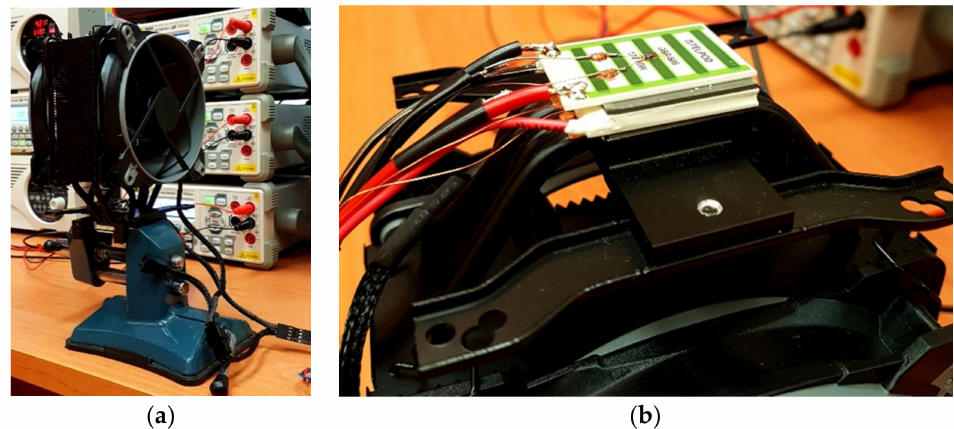
Figure 6. General view of cooling configuration E ( a ) and view of the heat source ( b ).